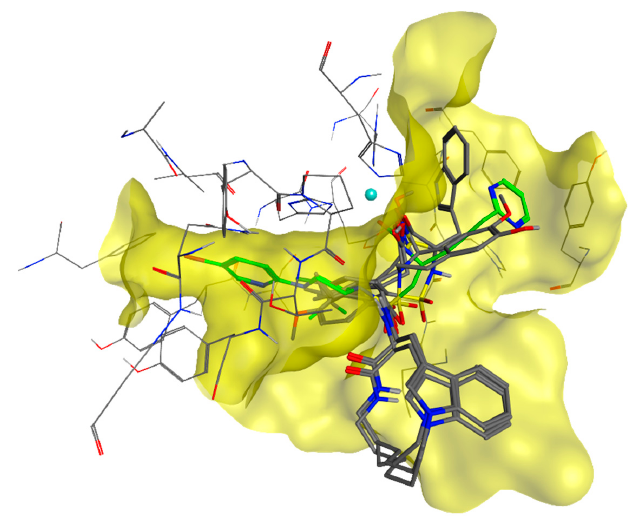
Figure 2. Overlay of all known MMP-7 inhibitors, found in the Protein Data Bank, within the active site. PDB codes: 1MMP, 1MMR, 1MMQ, 2DDY, 2Y6C, 2Y6D (ligand from 2Y6D depicted in green).